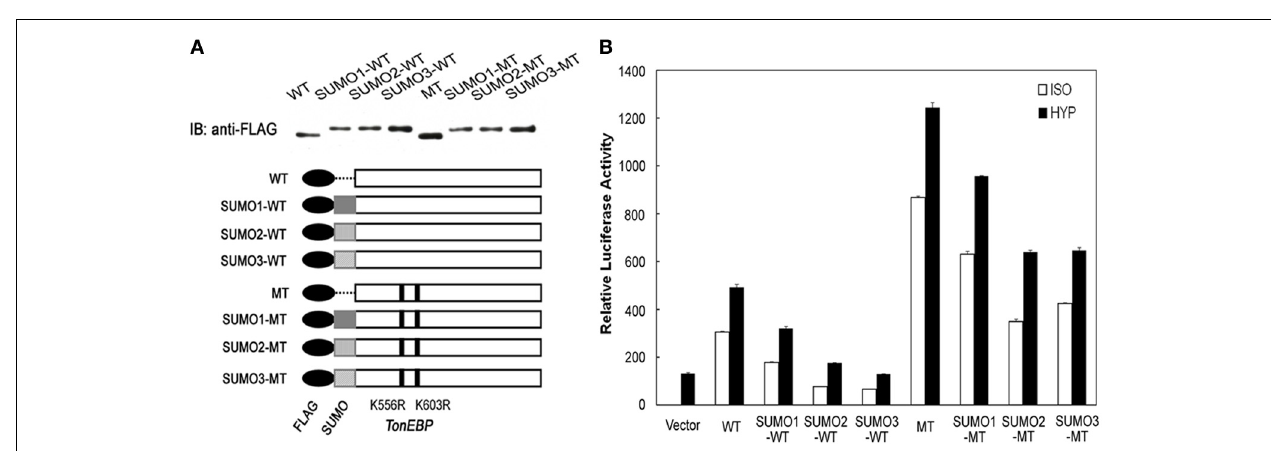
FIGURE 6 | SUMO isoform-dependent effects of sumoylation on the transcriptional activity of TonEBP. (A) Schematics and expression of constructs are shown as in Figure 5A , except that SUMO1, SUMO2, and SUMO3 were used to make fusion proteins. (B) HEK293 cells were transfected and analyzed as in Figure 5B .